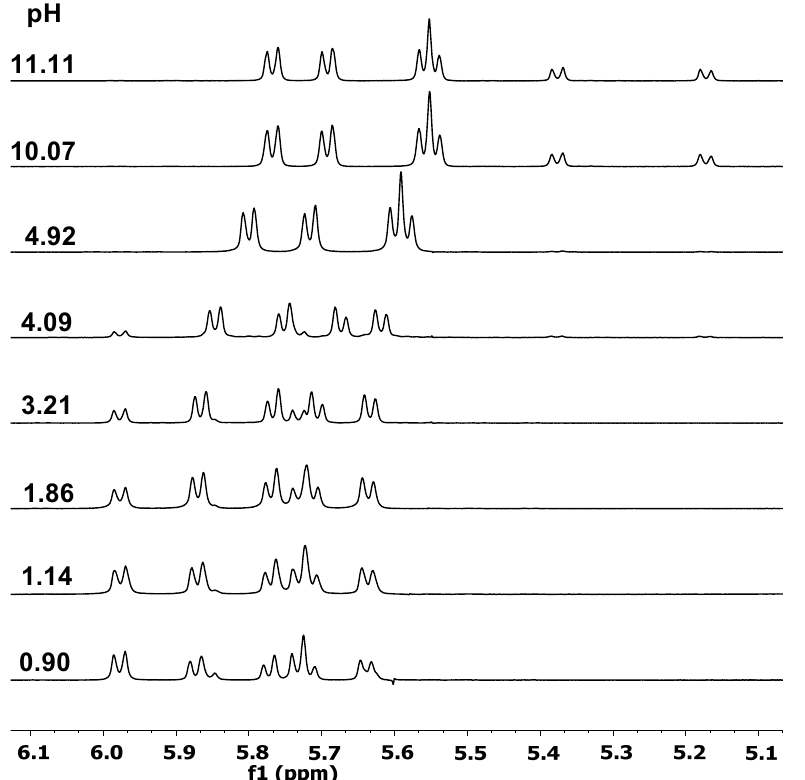
Figure 7. The pH-dependence of the 1 H NMR signals belonging to the neighboring ring protons of [( η 6 - p -cym)Ru] 2+ moiety registered with IdaP 3 ‒ at a 1:1 ratio (c Ru = 10 mM, I = 0.20 M KNO 3 ).